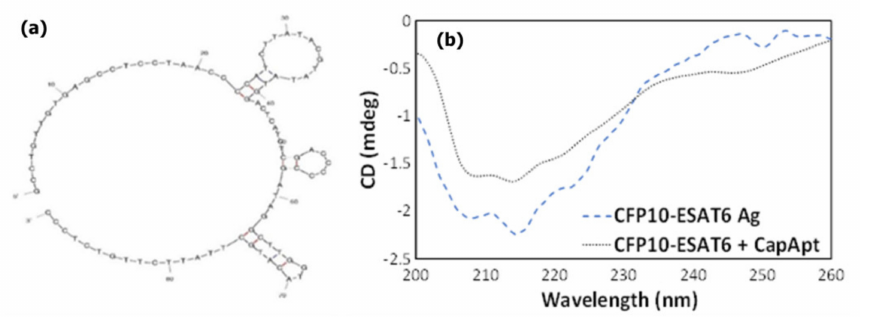
Figure 2. ( a ) Structure of capture aptamer for CFP10-ESAT6 antigen. ( b ) circular dichroism (CD) analysis indicates structural changes due to binding interaction between capture aptamer and CFP10- ESAT6